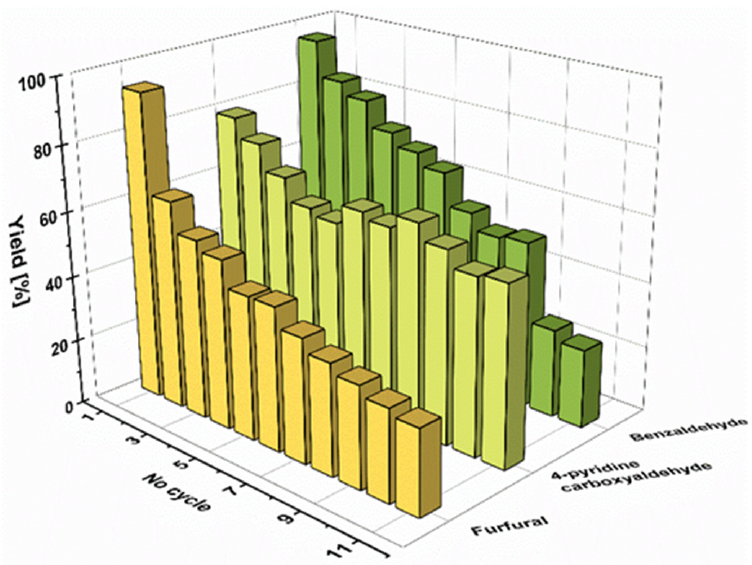
Figure 4. The yields of benzaldehyde in six consecutive cycles using N-AgNPs (performed accord- ing to the description of Table 3 Experiment 1).